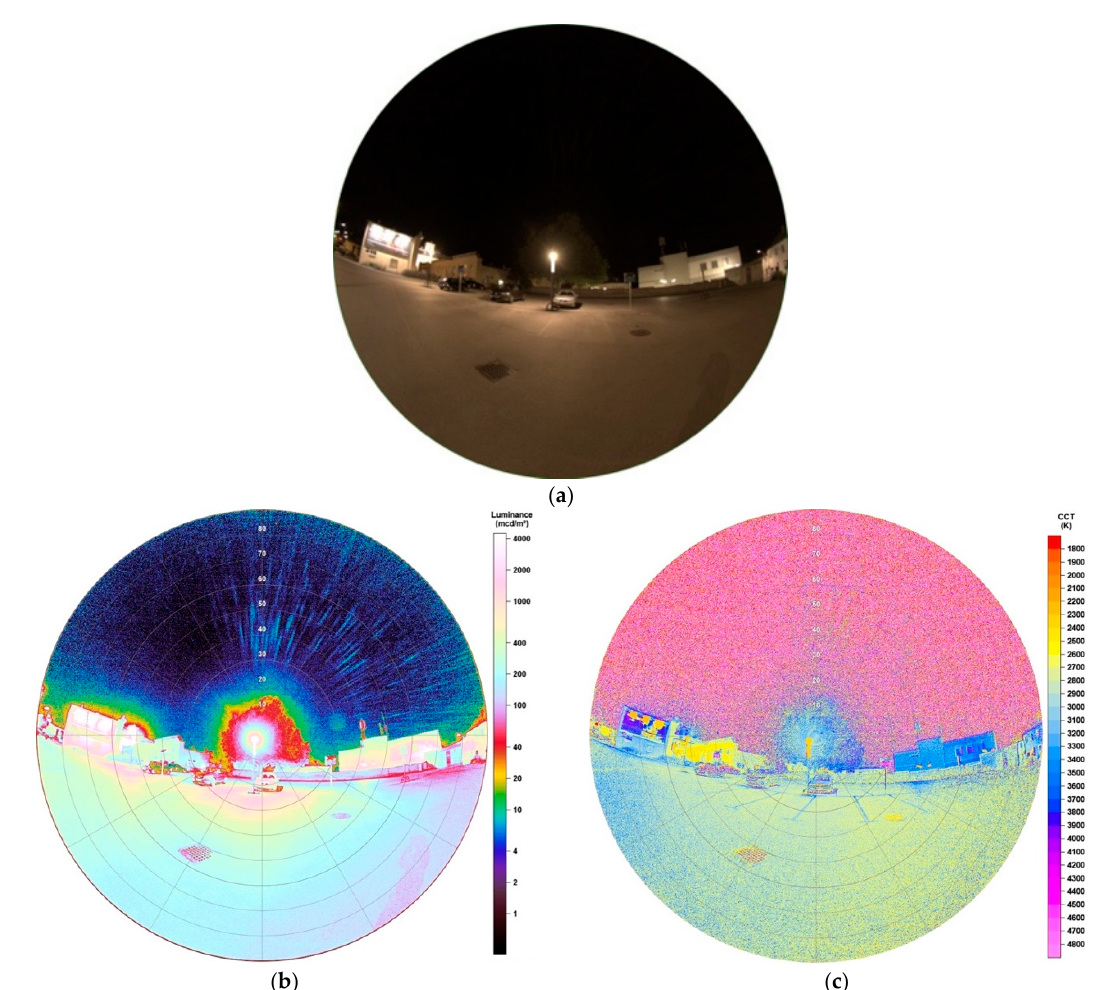
Figure 8. ( a ) Image of tube lamp during night-time taken with fisheye lens for detailed analysis (date: 29.07.2019, 23:23 h; exposure time: 0.3 s); ( b ) Luminance matrix of image (a) as displayed by SQC; ( c ) CCT matrix of image (a) as displayed by SQC.